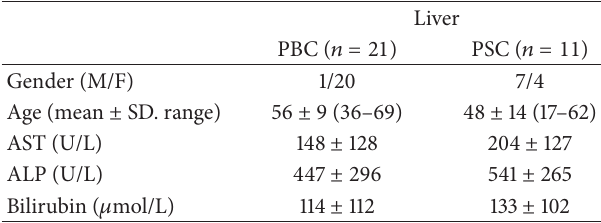
Table 1: Demographic and laboratory features of patients with primary PBC and PSC included in the part of the study analyzing expression of PXR and SULT2A1 in explanted